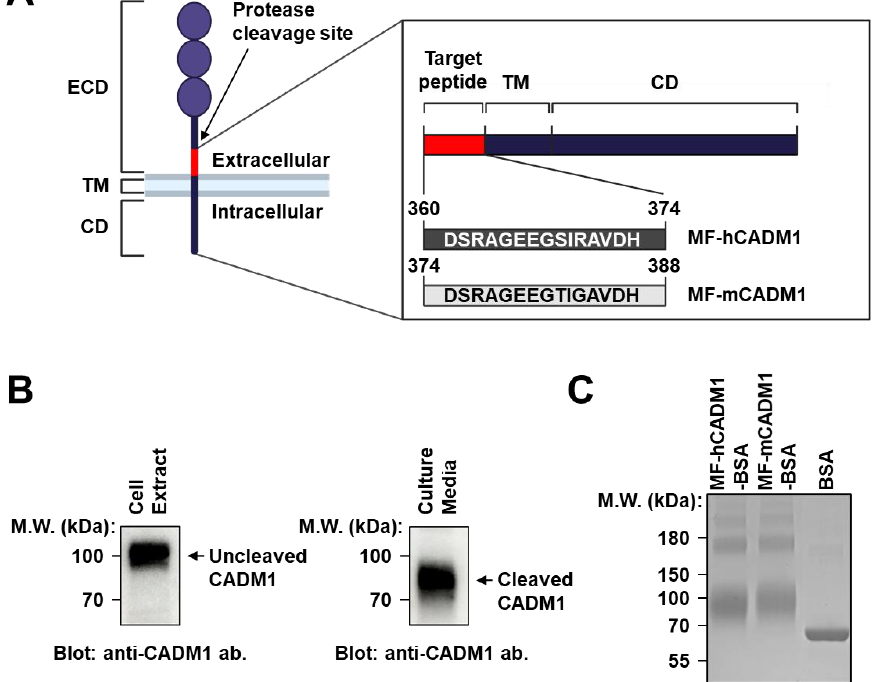
Figure 1. Cleavage of CADM1 protein and preparation of CADM1 peptide conjugates as antigens for antibody selection. ( A ) Schematic drawing of the membrane-proximal cleavage of CADM1 and its resulting membrane-bound fragment of CADM1 (MF-CADM1) on cancer cell surfaces. ( B ) NCI-H69 SCLC cell extracts (left) or the culture media (right) were individually subjected to immunoblot analysis with commercially available anti-CADM1 antibodies. Beta-actin was used as a loading control. ( C ) MF-hCADM1-BSA, MF-hCADM1-BSA, or BSA as a negative control, was subjected to SDS-PAGE, and the mobility shift was visualized by Coomassie Brilliant Blue (CBB) staining.